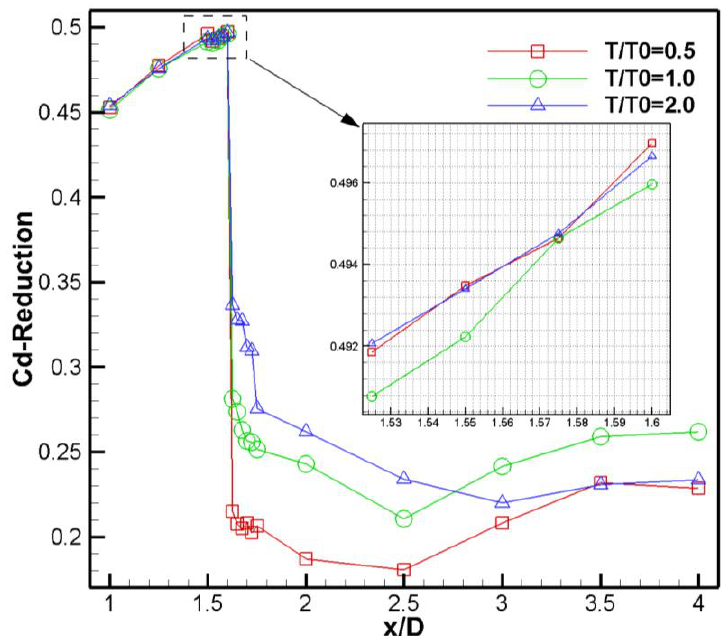
Figure 15. Drag Reduction of tandem configuration varying with x / D